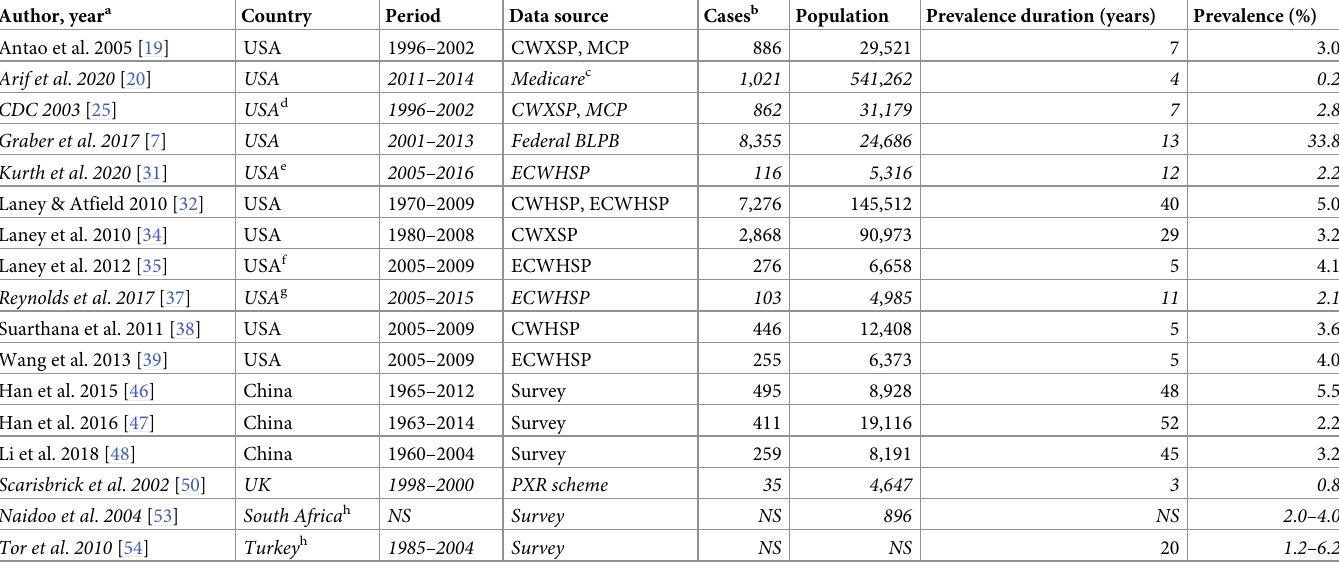
Table 3. Summary of included studies on overall prevalence of coal workers